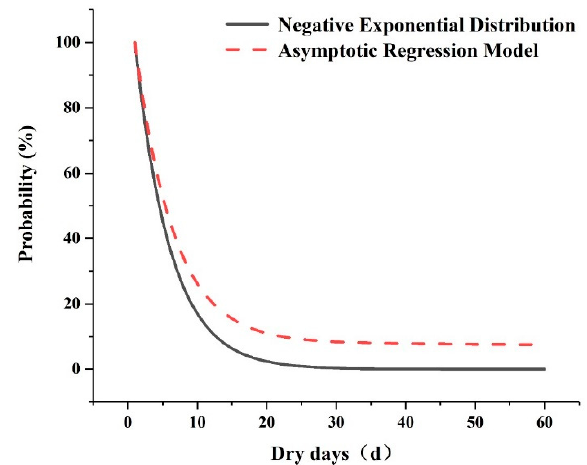
Figure 6. Probability function of dry days.